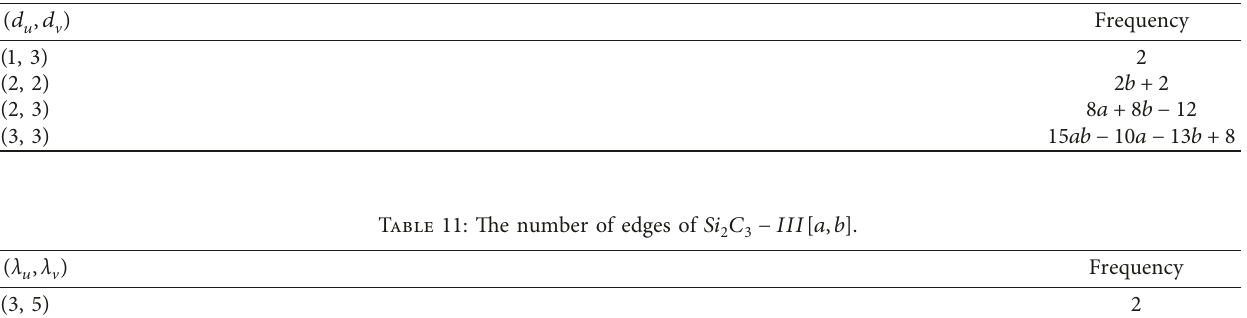
Table 10: The number of edges of Si